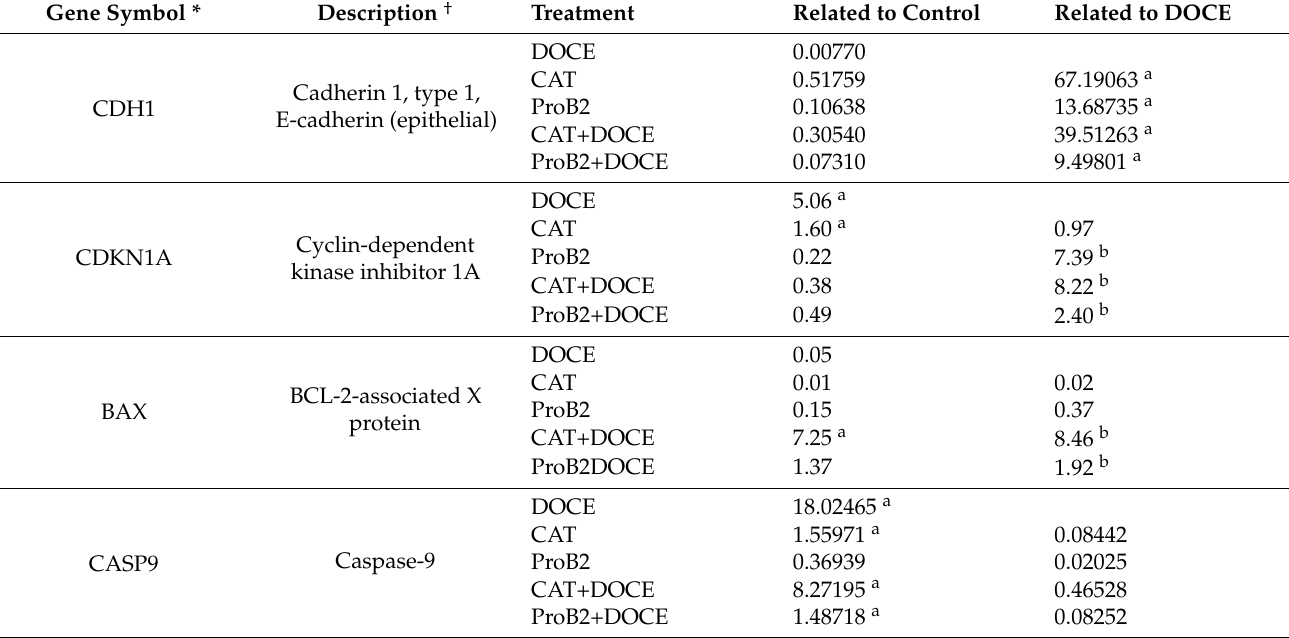
Table 2. Gene list that represents at least 1.5-fold of change of genes encoding cell proliferation-, apoptosis- and EMT-related proteins in MCF-7 cells treated either with ProB2 (50 µ M), CAT (50 µ M), DOCE (120 nM), ProB2 (50 µ M)+ DOCE (120 nM) or CAT (50 µ M)+ DOCE (120 nM) for 72